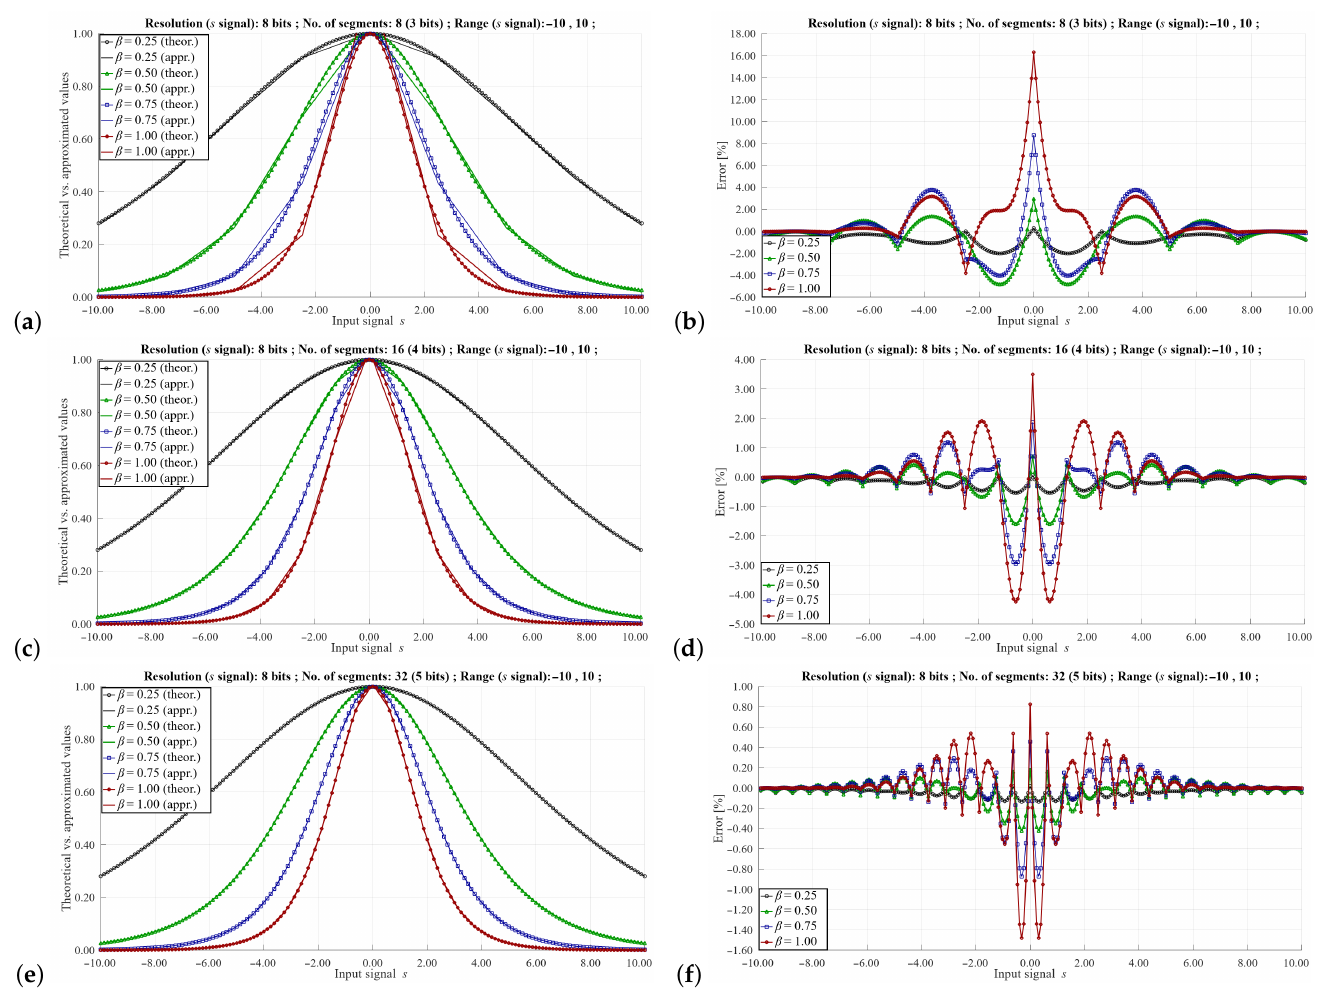
Figure 6. Approximation of the Λ ( s ) function for the s signal coded on 8-bits, in the range ( − 10, 10), for ( a , b ) 8 segments (3-bits), ( c , d ) 16 segments (4-bits) and ( e , f ) 32 segments (5-bits). Diagrams to the left illustrate the approximation process of the Λ function, for β = 0.25,0.5,0.75,1.0, while diagrams to the right illustrate the resultant